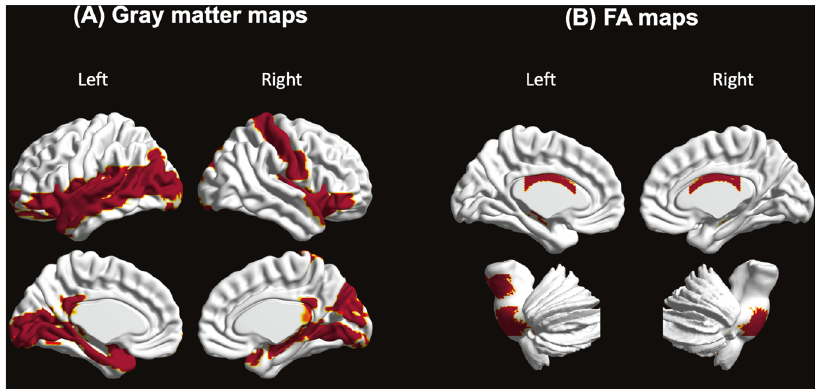
Fig. 4 Association of illness duration with brain age gaps across different brain regions in participants with schizophrenia. A There were signi fi cantly positive correlations between illness duration and brain age gaps in 22 brain regions. B Ten white matter tracts were positively associated with illness